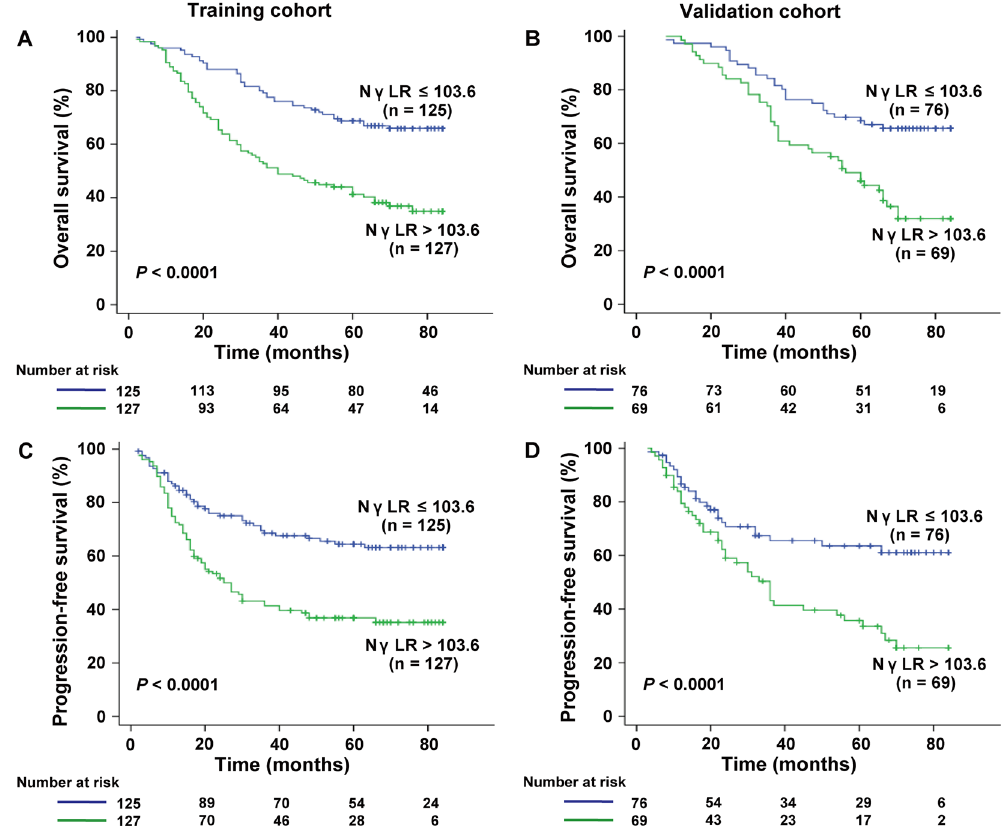
Figure 4. Prognostic significance of N γ LR in early HCC patient. Kaplan-Meier curves depict overall survival ( A , B ) and progression-free survival ( C , D ) in early HCC patients (BCLC 0 + A) with N γ LR > 103.6 or ≤ 103.6 in the training and validation cohorts.